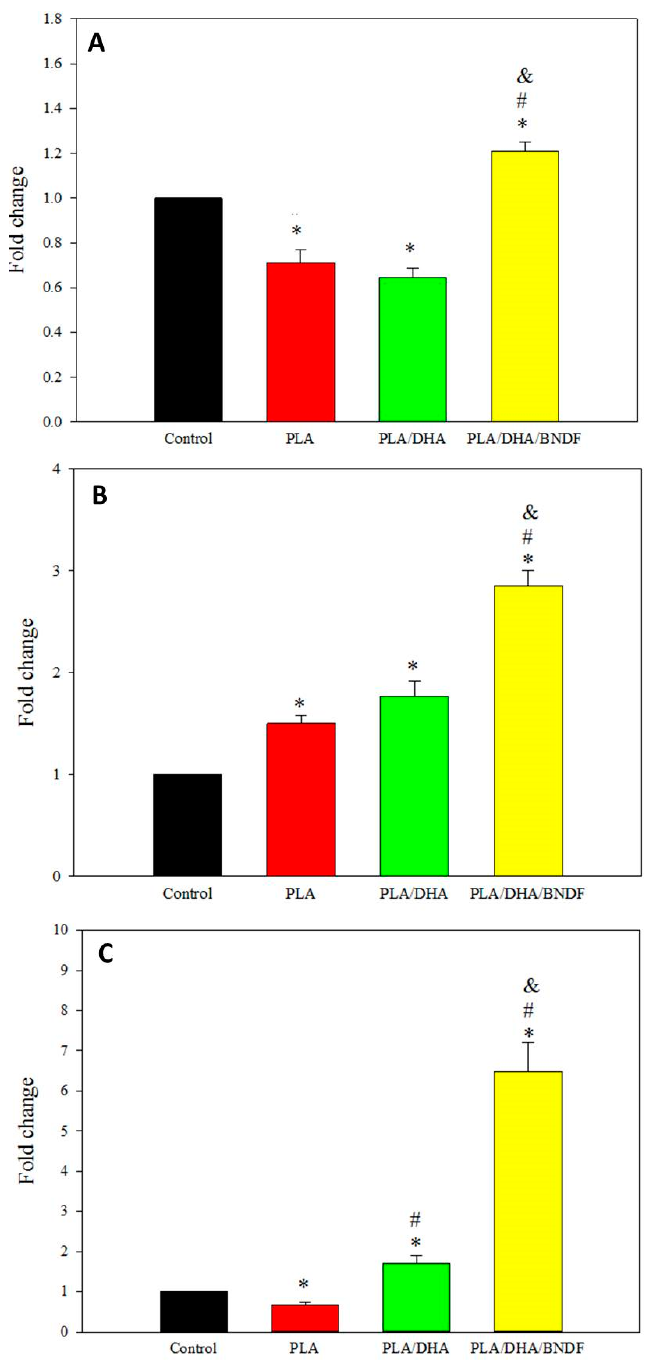
Figure 7. The relative mRNA expression of growth-associated protein-43 (GAP-43) ( A ), activating transcription factor-3 (ATF-3) ( B ), and neurotrophin-3 (NT-3) ( C ). The expression of these genes associated with neurite outgrowth was determined from real-time polymerase chain reaction (RT- PCR) by co-culturing primary cortical neurons with PLA, PLA/DHA, and PLA/DHA/BDNF core– shell fibrous membranes (CSFMs). The control is primary cortical neurons cultured with cell culture medium. * p < 0.05 compared with control; # p < 0.05 compared with PLA, & p < 0.05 compared with PLA/DHA.